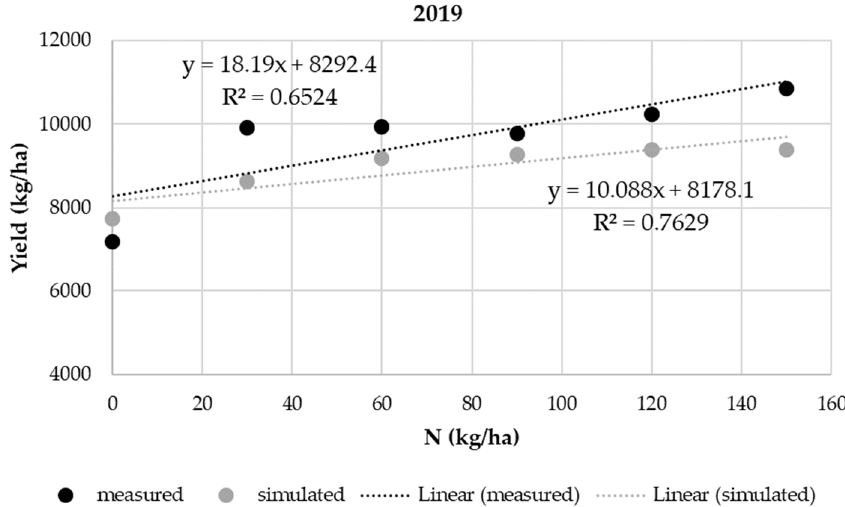
Figure 5. Comparisons between simulated and measured maize grain yield (2019).